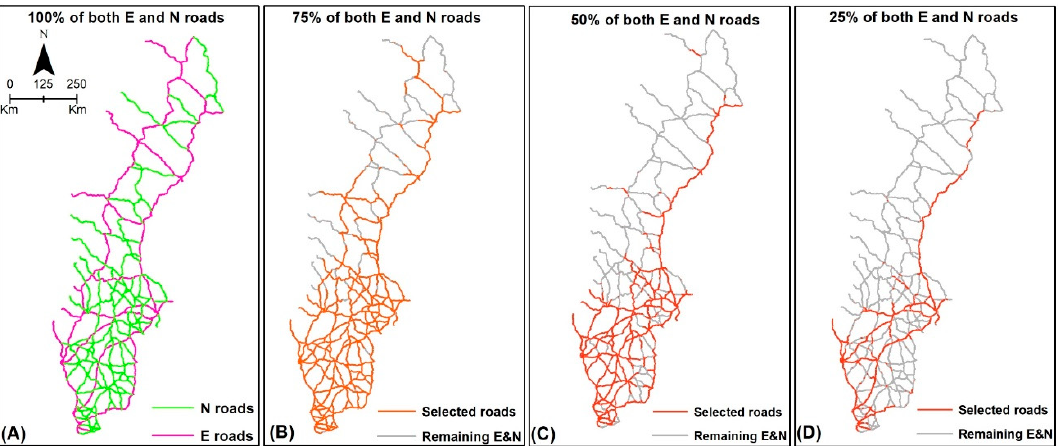
Figure 1. European (E) and National (N) roads in Sweden and the road segments with the top 100% ( A ), 75% ( B ), 50% ( C ), and 25% ( D ) truck traffic volume.